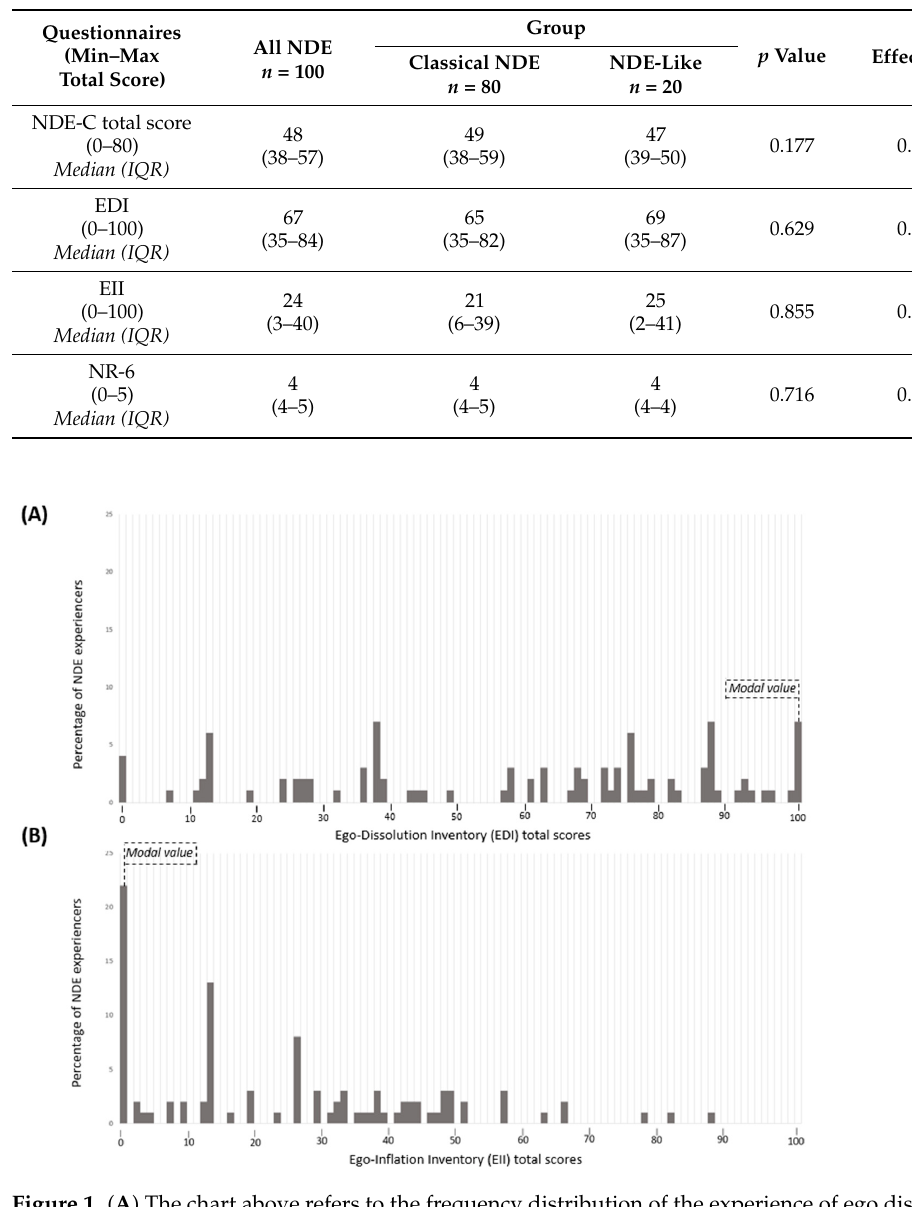
Figure 1. ( A ) The chart above refers to the frequency distribution of the experience of ego dissolution (EDI total scores) in all experiencers. Note that the only modal value is 100, even if the grouping of the different total scores in one single histogram bar visually pretends there are other modal values (same histogram bar heights for the bars at 38% and 88%). ( B ) The chart below refers to the experience of ego inflation (EII total scores) in all